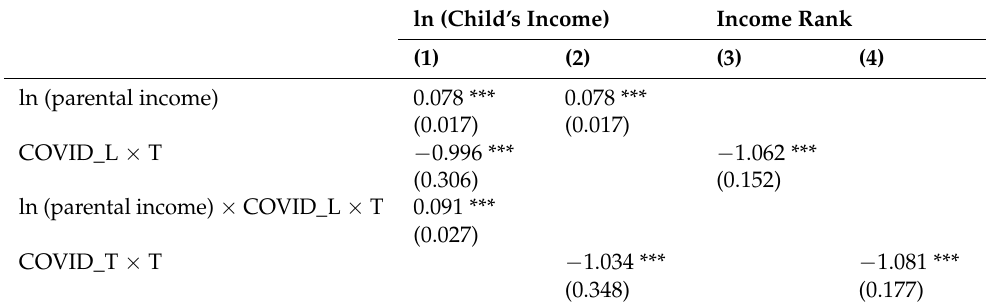
Table A2. The effects of COVID-19 shock on intergeneration income mobility except for